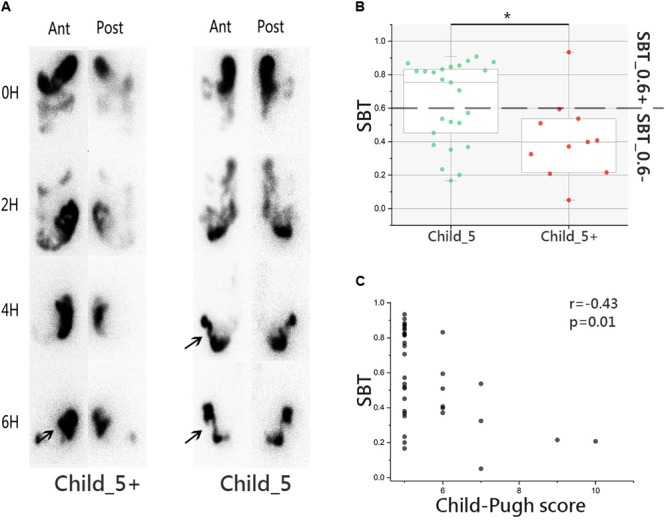
Small bowel transit (SBT) study in LC patients. (A) Images of emission computed tomography of paired anterior and posterior images at 0, 2, 4, and 6 h for liquid labeled with 99mTc. Arrow was used to indicate the terminal ileum and cecum-ascending colon. (B) SBT value comparison between Child_5 group and Child_5+ group, box plot illustration was provided in Figure 1, Wilcoxon rank-sum test, ∗p < 0.05. (C) Correlation analysis between SBT and Child–Pugh score, r = –0.43, p = 0.01, Spearman’s rank test. LC (n = 36, Child_5, n = 25; Child_5+, n = 11).